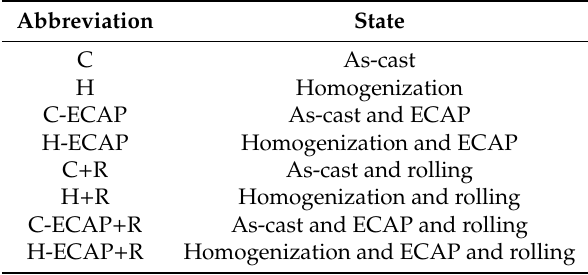
Figure 1. Processing schematic of ( a ) RD-ECAP and ( b ) post-ECAP rolling. Table 1. Abbreviations for samples used in this Table 1. Abbreviations for samples used in this work.